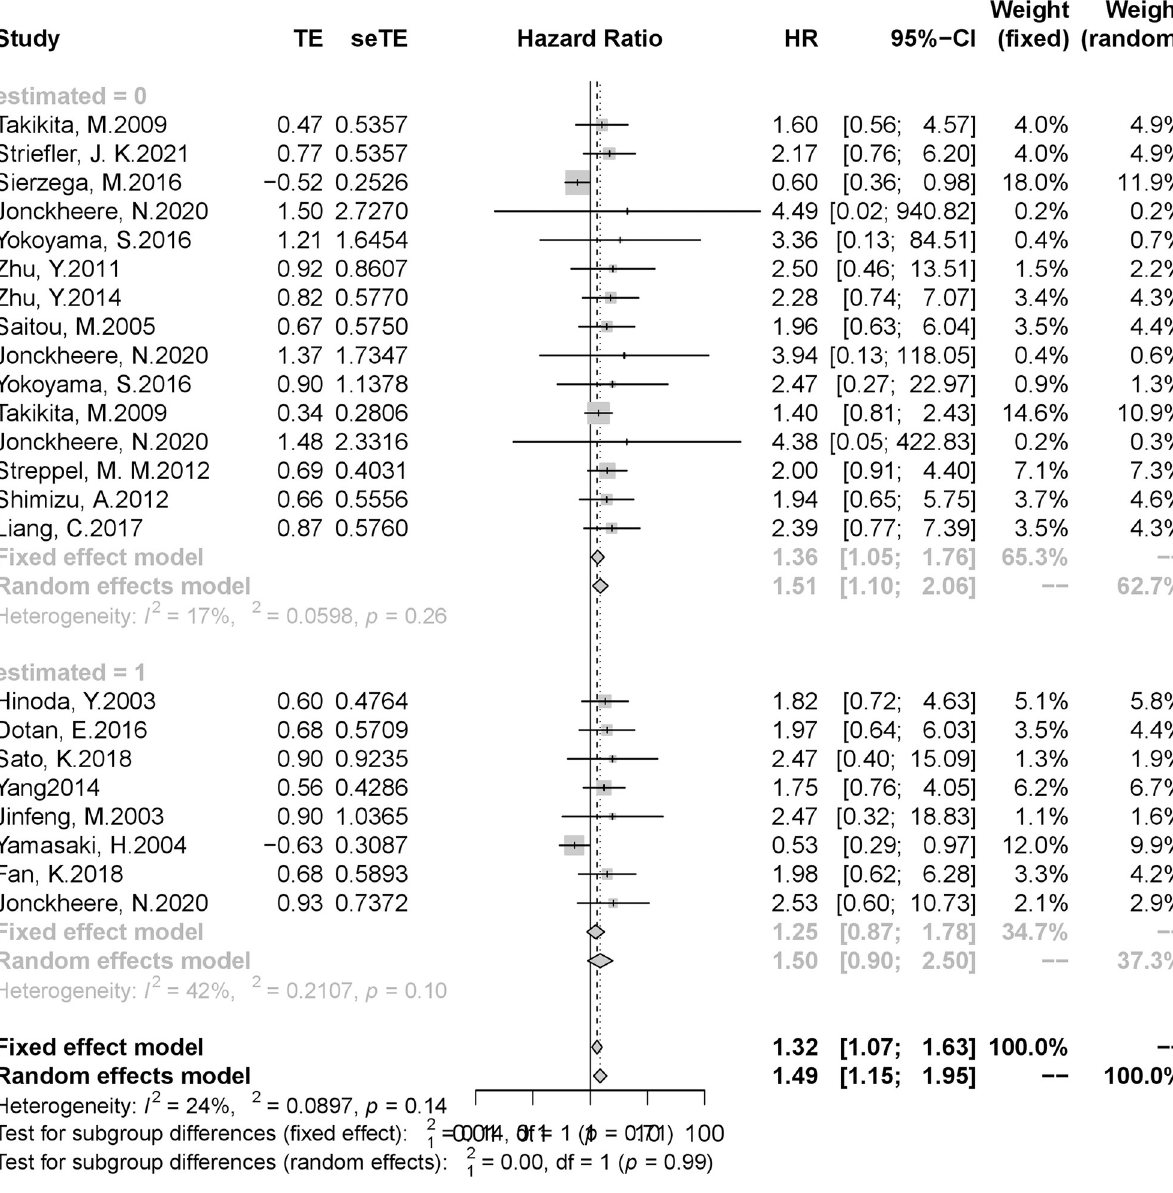
Fig 4. Result of subgroup analysis (2). (A)Subgroup analysis was performed based on whether HR and 95%CI was the estimated value. (B) estimated = 0 , HR and 95%CI were provided directly. estimated = 1 , HR or 95%CI were estimated. (C) estimated = 0 : HR = 1.36,95%CI 1.05–1.76; estimated = 1: HR = 1.25,95%CI